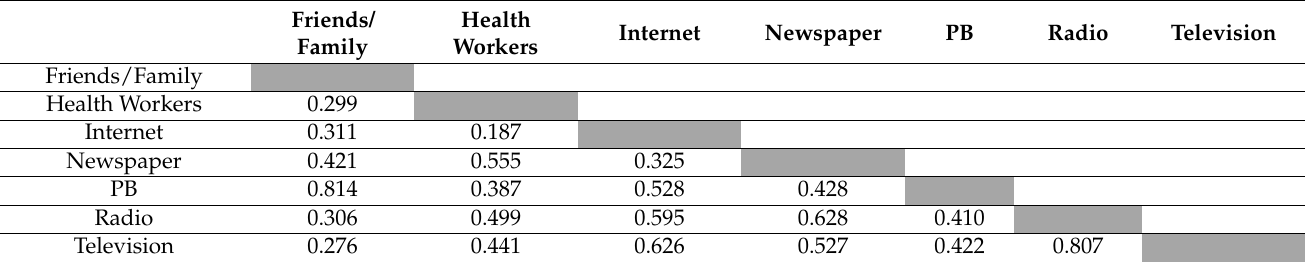
Table 11. Discriminant validity.